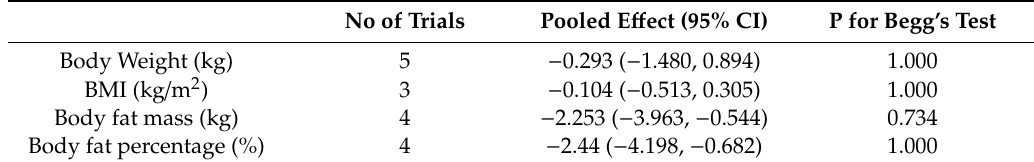
Table 2. Results of publication bias test.